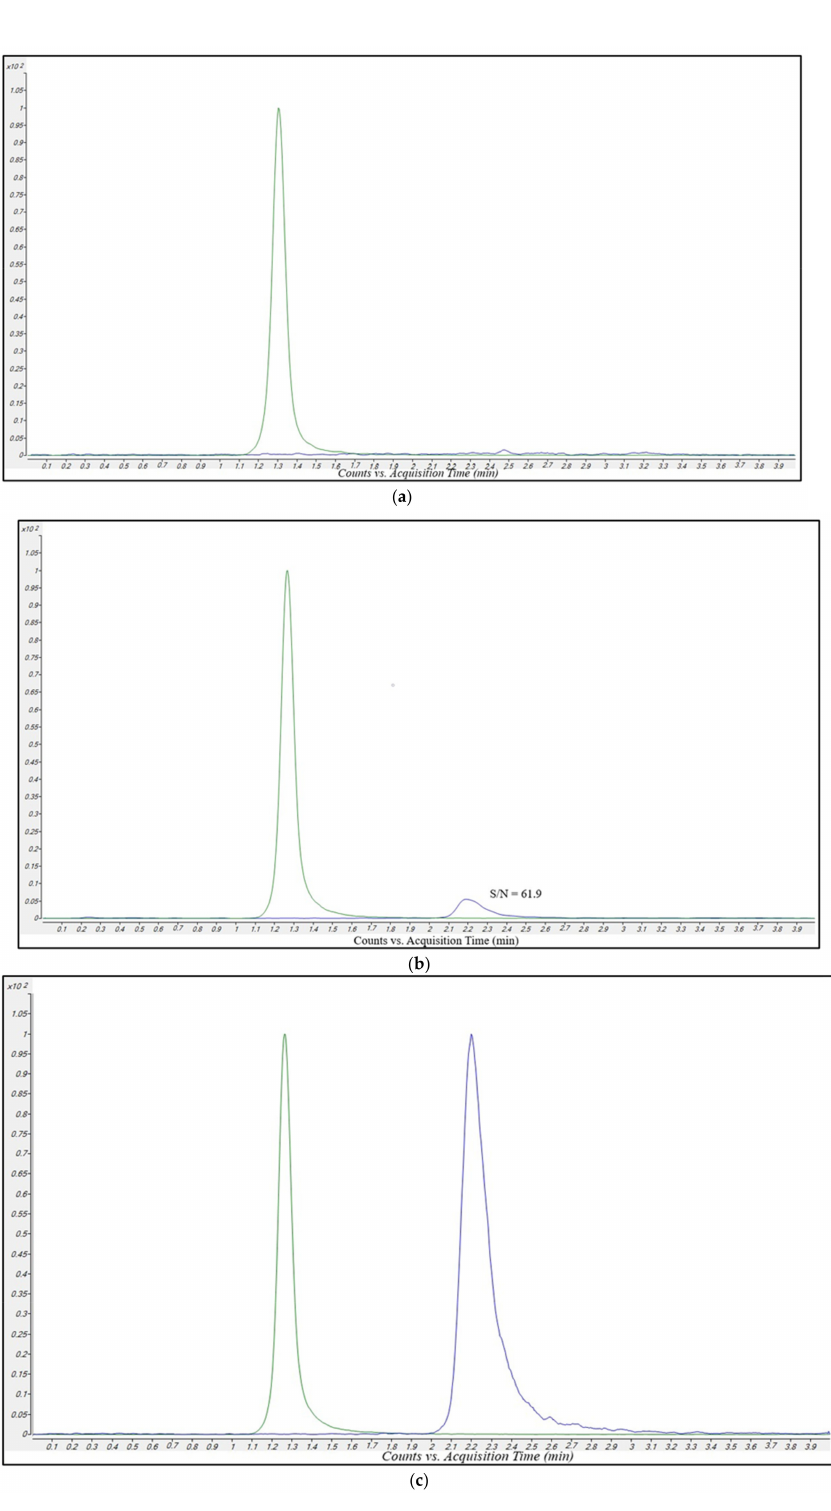
Figure 2. Overlayed MRM chromatograms for VBR (blue line) and AVI-C13 (green line) obtained in the analysis of ( a ), a blank sample extracted with the methanol-IS solution, showing the absence of peaks related to MRP and the presence of a well-defined peak of AVI-C13; ( b ) an LLOQ sample with printed S/N ratio (SNR); ( c ) a real patient sample showing good peak shape and resolution of specific